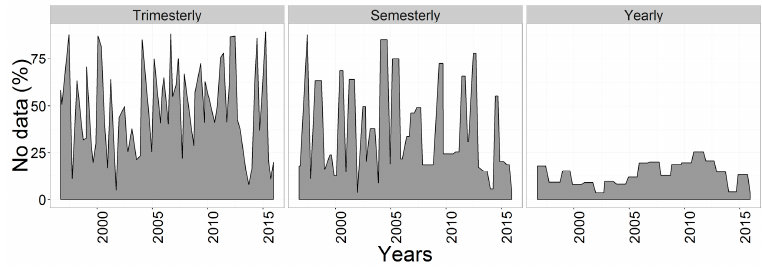
Figure 5. Remaining no data percentages in mosaics temporalities.